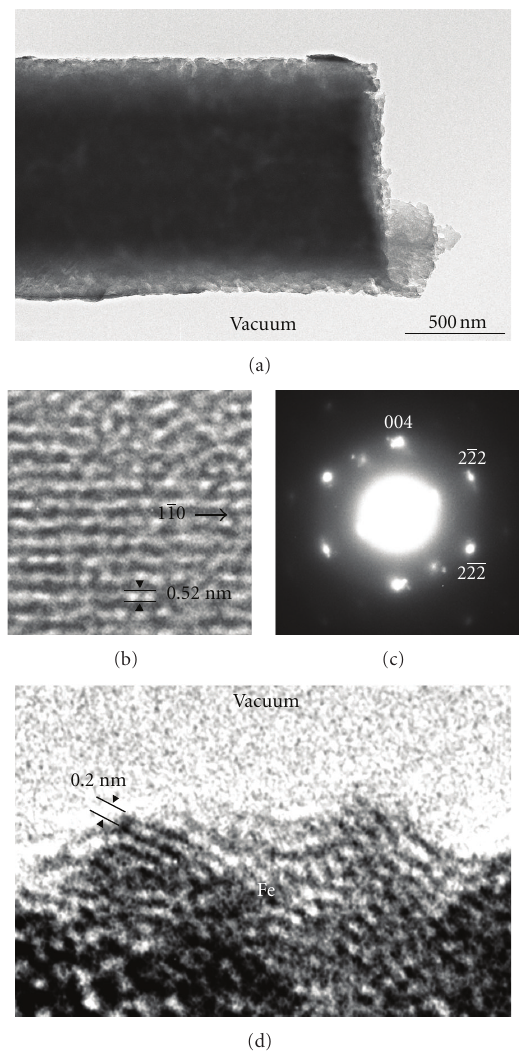
Figure 2: (a) Bright-field image, (b) high-resolution image, and (c) selected-area electron di ff raction pattern of as-precipitated Fe- doped C 60 nanowhisker. The diameter of the nanowhisker is 1.2 μ m. (d) High-resolution image of Fe particles in the nanowhisker. The lattice fringes of (110) Fe with a spacing of 0.20 nm are